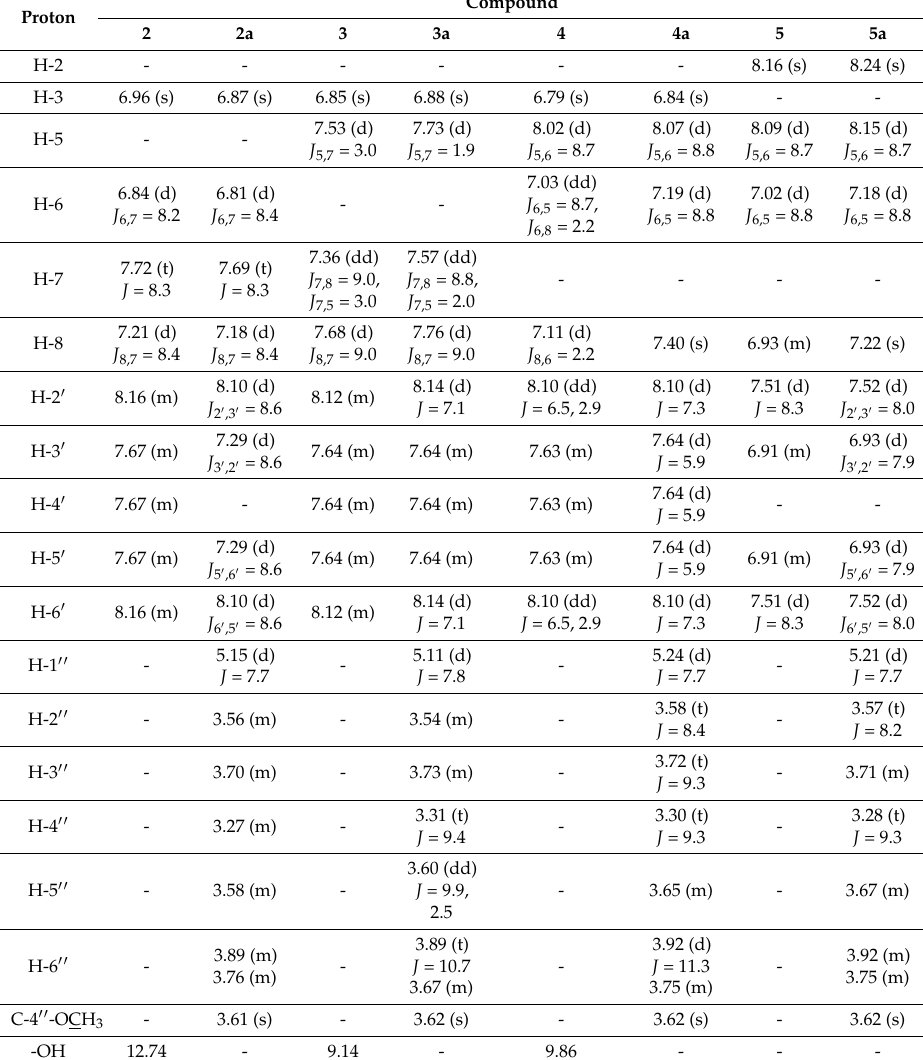
Table 3. 1 H-NMR shifts ( δ ) of 5-hydroxyflavone ( 2 ), 6-hydroxyflavone ( 3 ), 7-hydroxyflavone ( 4 ) and 4 (cid:48) ,7-dihydroxyisoflavone (daidzein) ( 5 ) and products of their biotransformations ( 2a , 3a , 4a , 5a ) in Acetone- d 6 , 600 MHz (Supplementary Materials).